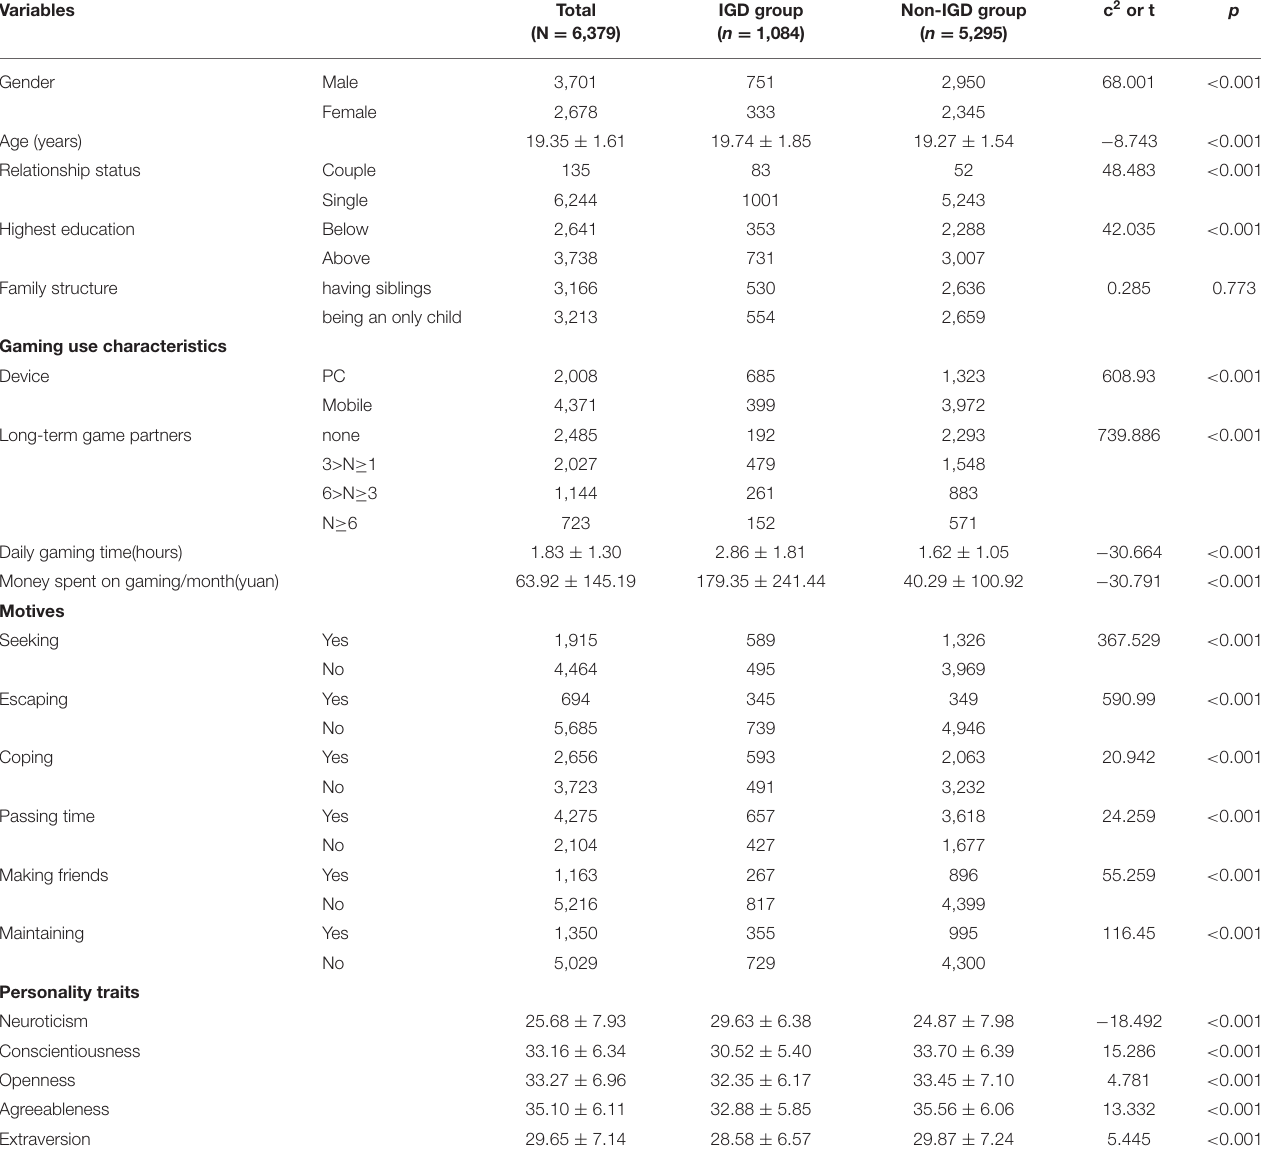
TABLE 1 | Socio-demographic and Internet gaming characteristics of participants and comparison between IGD group and Non-IGD group by variables.